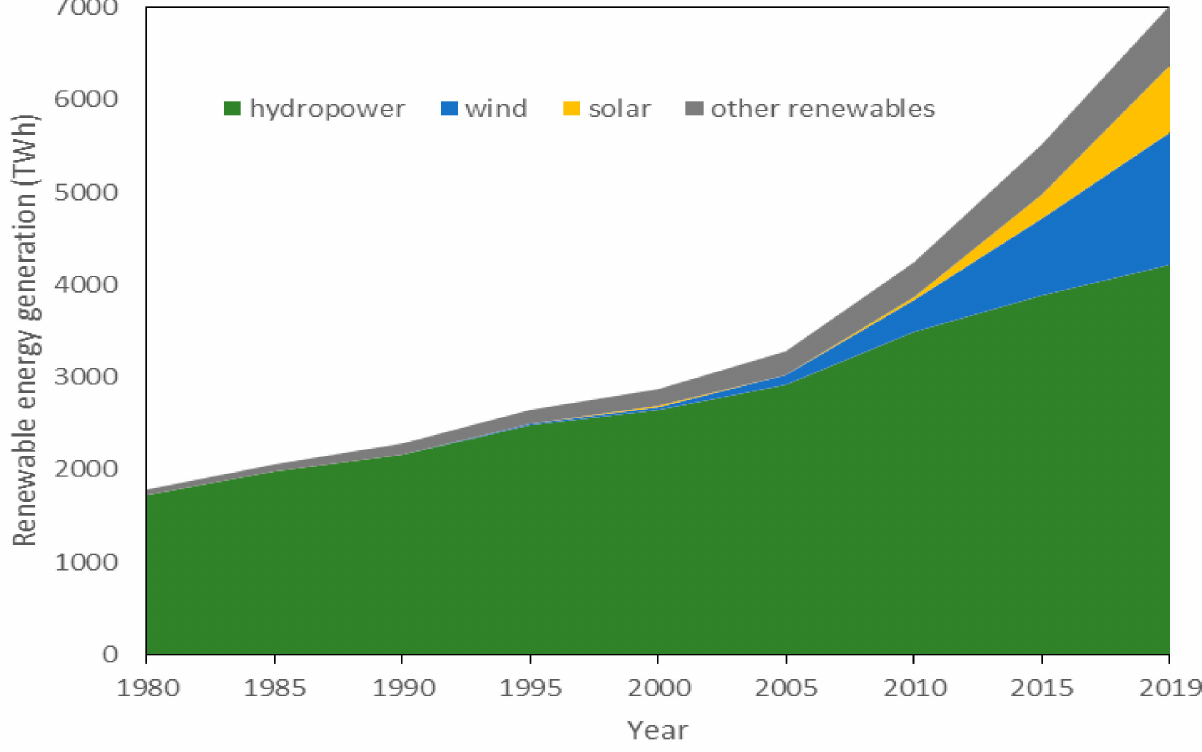
Figure 4. RE generation in the world. Own elaboration based on data from